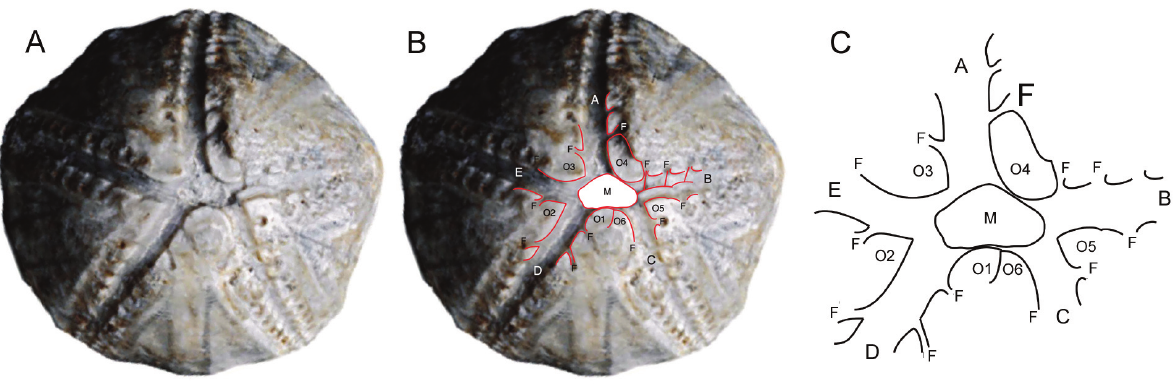
Fig. 5. Oral area of Cystoblastus kokeni Jaekel, PIN3032/1. A , oral view in standard orientation. B , the same with interpretation of oral plates and primary brachiole facets. C , the interpretation, which shows that Cystoblastus primary brachioles displayed the ‘B D different’ pattern in which the first two facets (F) are to the left as viewed in the growth direction (aborally) in ambulacra B and D, whereas only the first facet is to the left in ambulacra A, C and E. A–E, ambulacra according to Carpenter (1884, 1891); M, mouth;